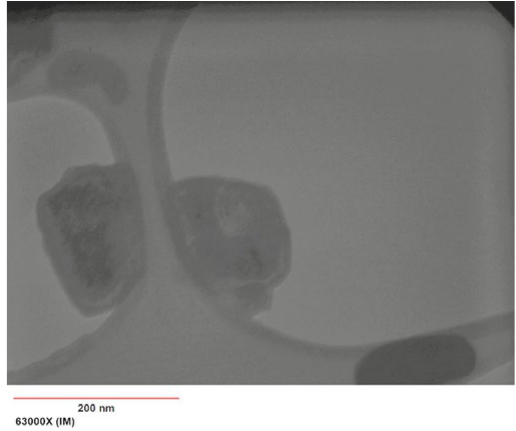
Fig. 1: TEM image of exeosomes extracted from U87 cell